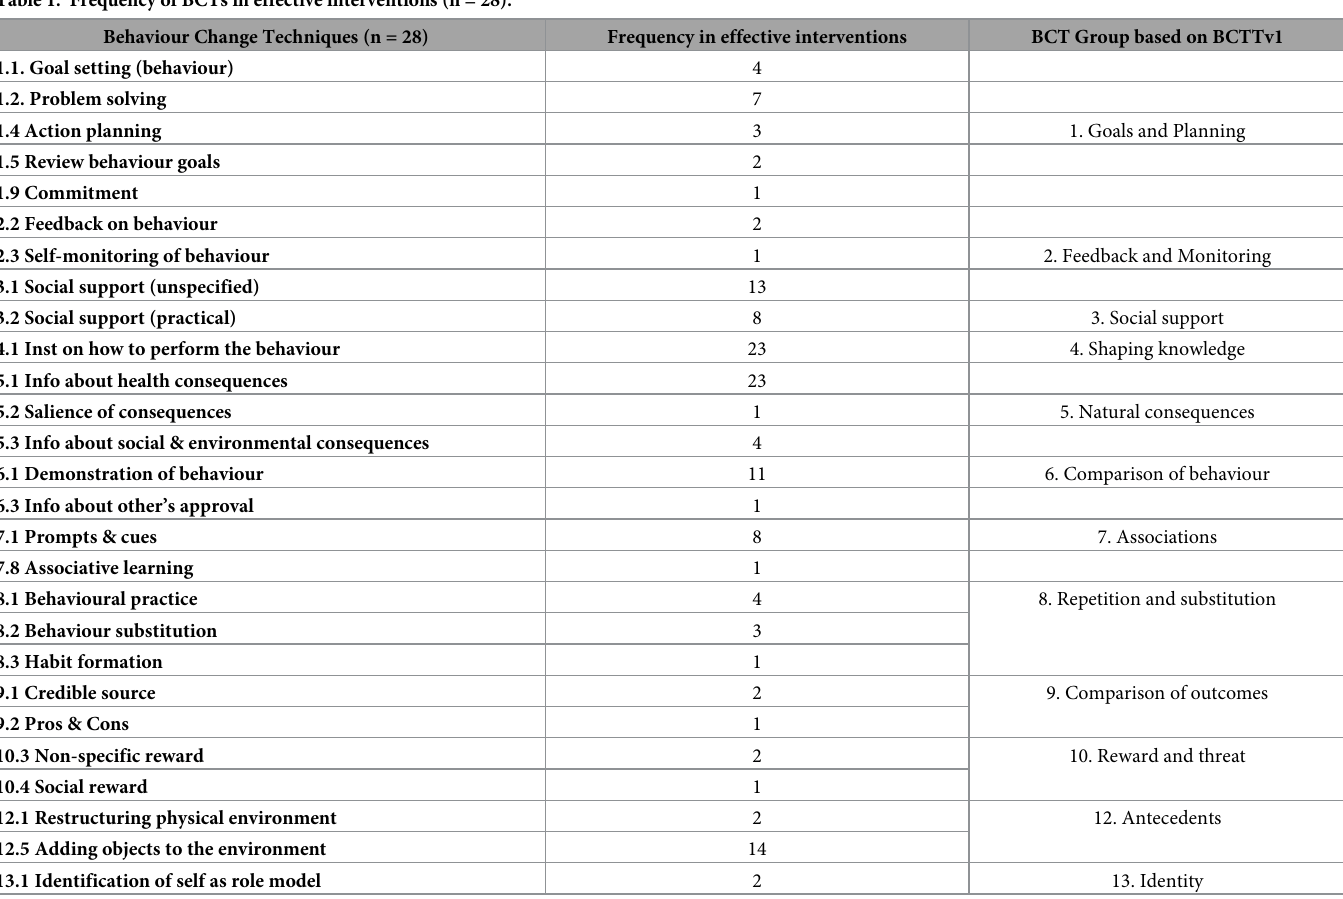
Table 1. Frequency of BCTs in effective interventions (n =